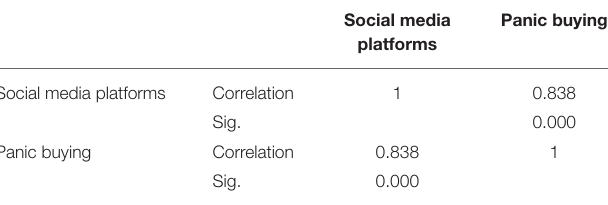
TABLE 5 | Association between social media and panic